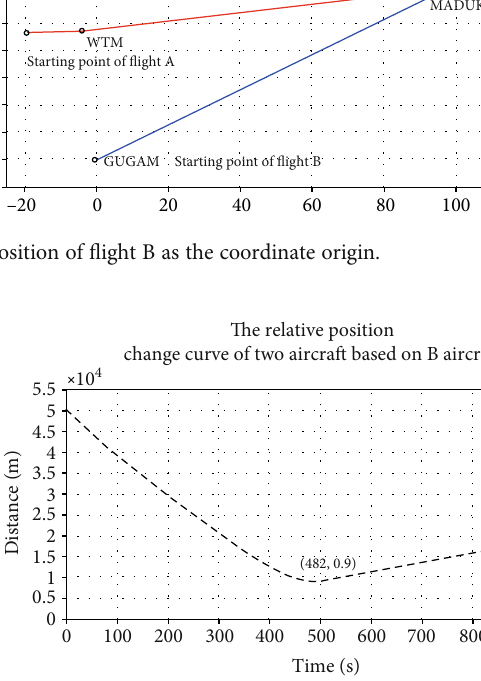
Figure 8: Change of relative position of fl ight based on B aircraft